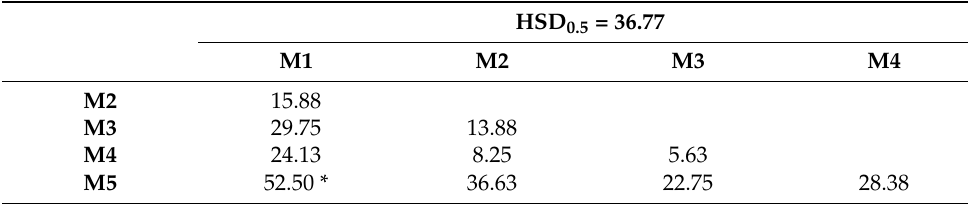
Table 4. DPPH results according Tukey’s